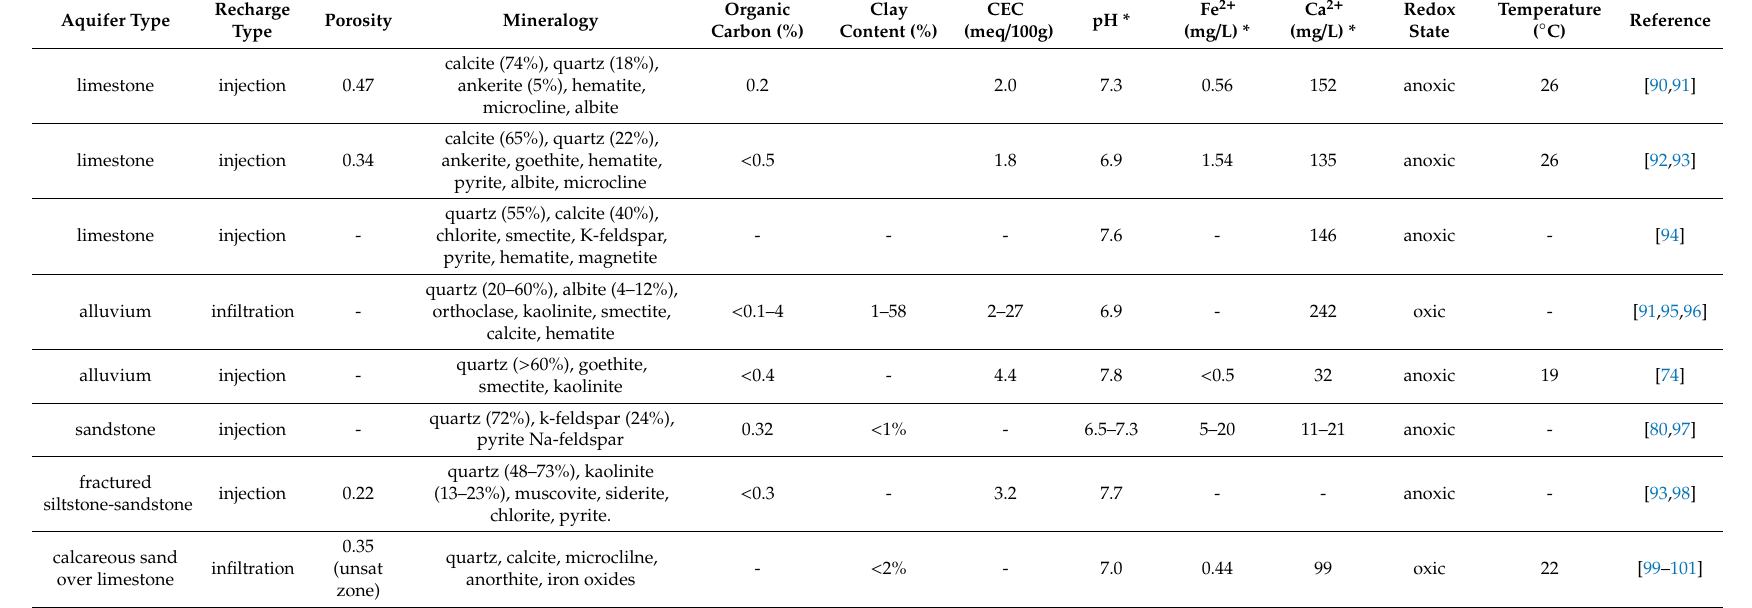
Table 3. MAR system hydrogeological and geochemical